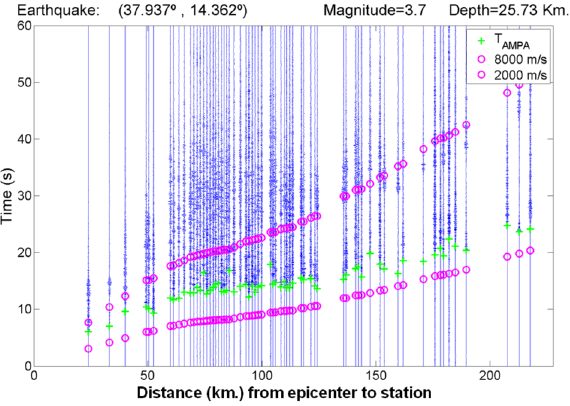
Figure 12. Automatic P-phase picking using AMPA for the earth- quake of magnitude 3.7 and depth 25.73 shown in Figure 5a. Stations are ordered starting from the closest to the most distant to the epi- center of the earthquake.